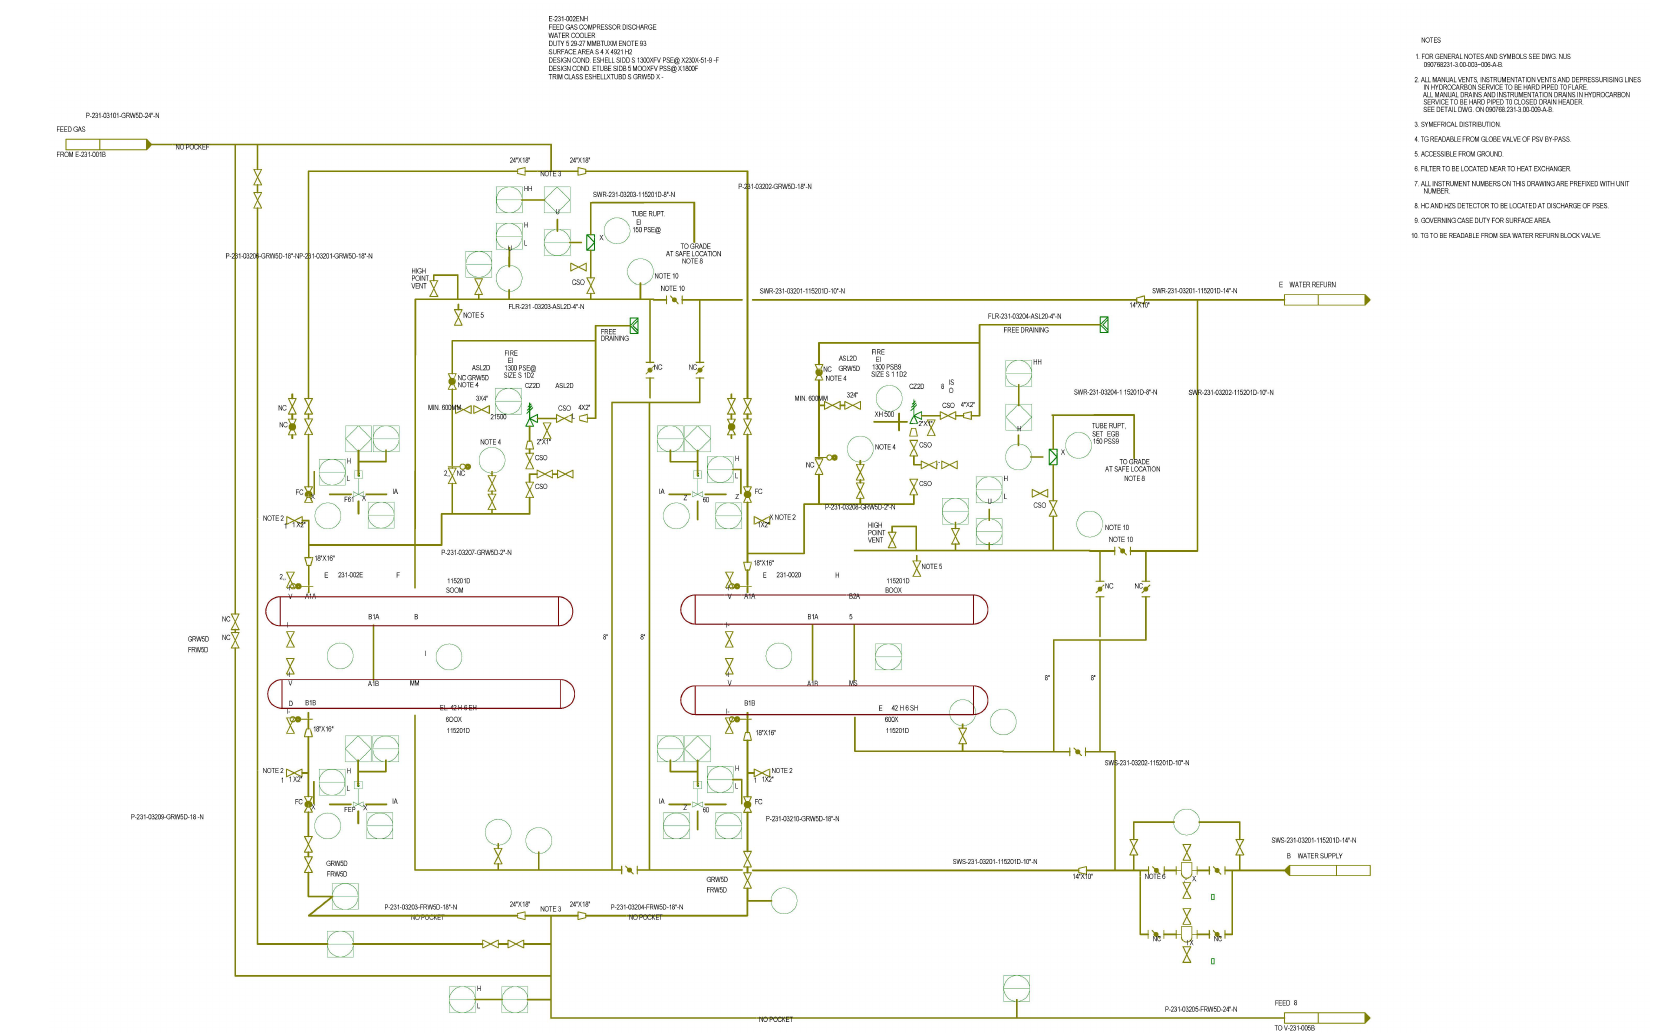
Figure 14. Converted results of SP